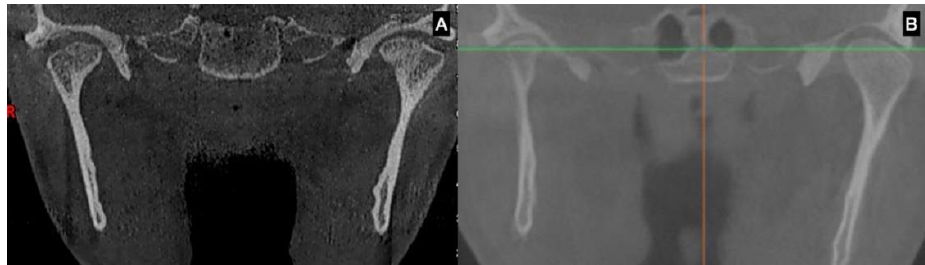
Figure 3. Hyperplastic growth of the condyle on the left side in different subjects showing progressive facial asymmetry. ( A ) Young subject with an augmented condyle on the left side (note the augmented articular space in the right TMJ with a normal size of the condyle). ( B ) Augmented condyle on the left side with more differences in height and width compared to the right condyle in an older subject.